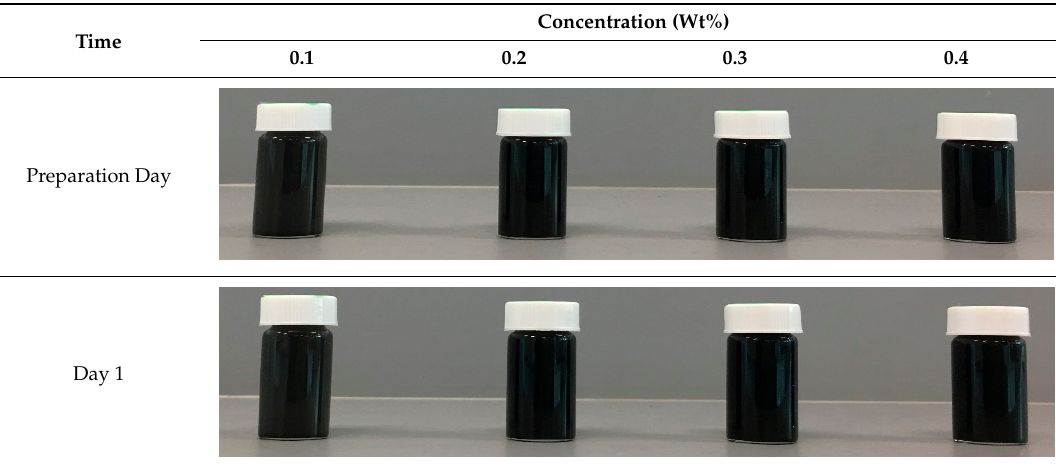
Table 1. Visual inspection of the prepared